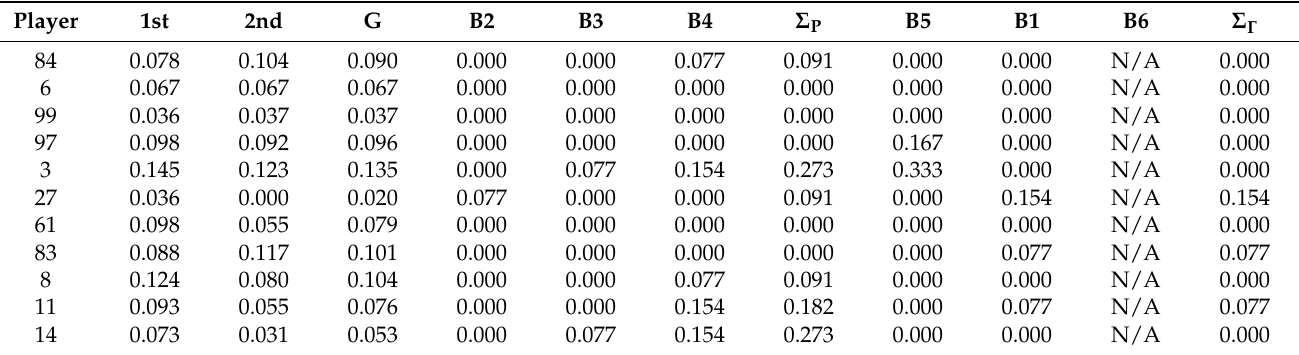
Table A7. Team A’s Degree Prestige Matrix of values.